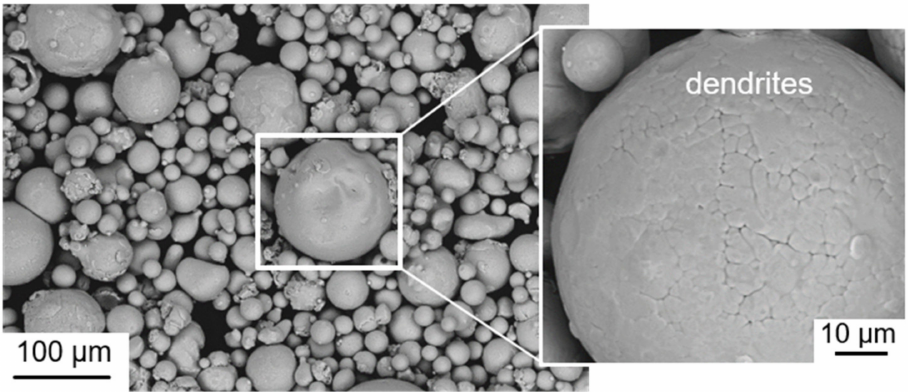
Figure 1. BSE-SEM micrographs of the Fe-25Al-1.5Ta alloy powder particles produced by